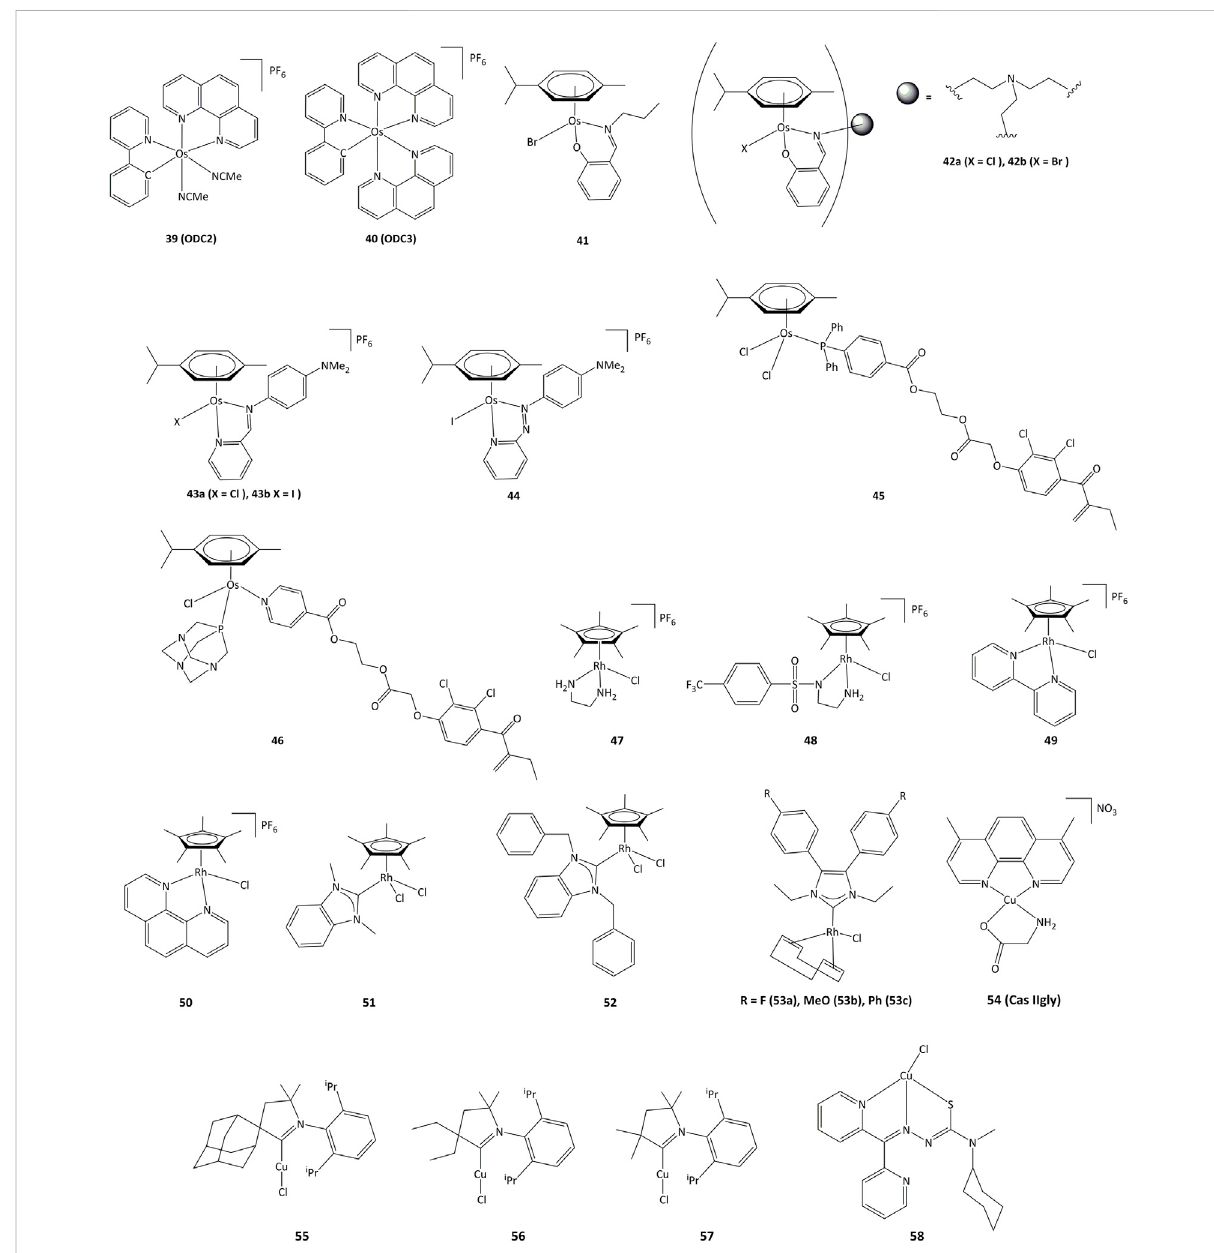
FIGURE 8 Osmium, rhodium and copper complexes studied as anticancer